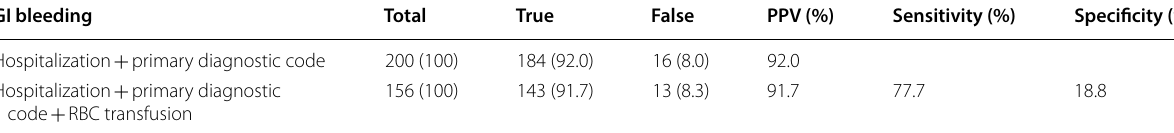
Table 3 Validation of diagnostic codes for gastrointestinal bleeding